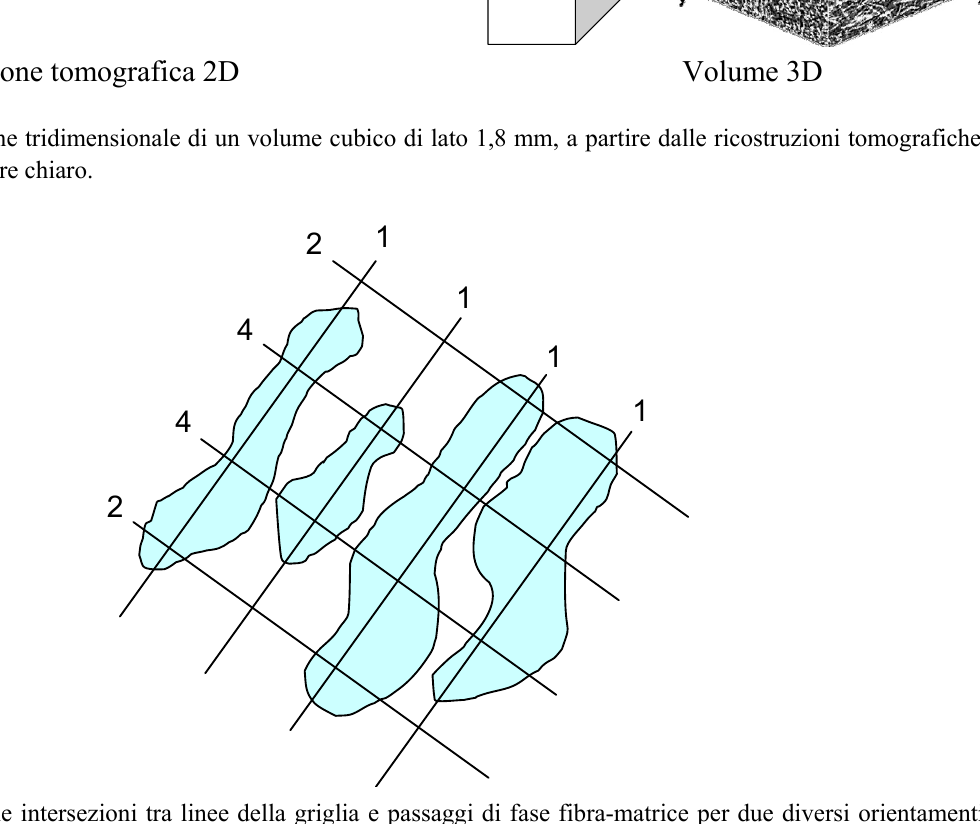
Figura 8: Conteggio delle intersezioni tra linee della griglia e passaggi di fase fibra-matrice per due diversi orientamenti della griglia di